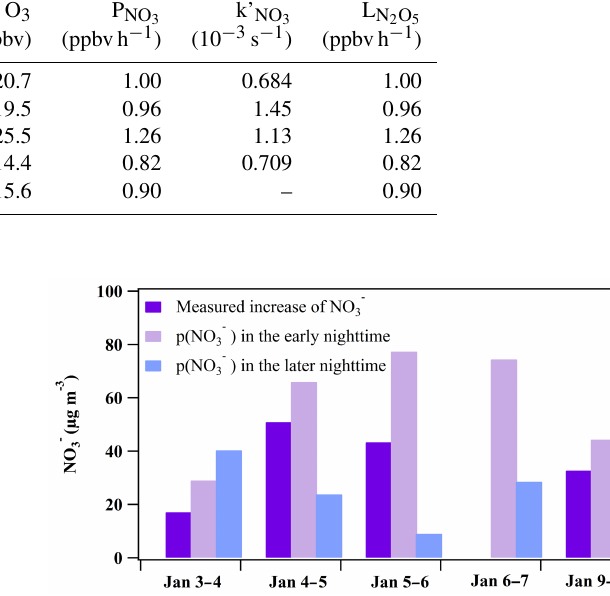
Figure 6. Comparison between the measured NO − the NO − formation potential in the early nighttime (periods in 3